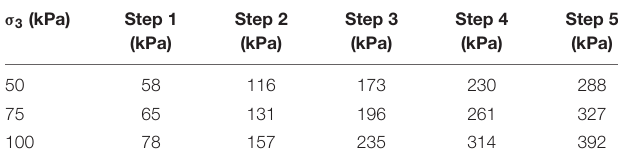
TABLE 2 | Gradual deviator loading steps applied for different confining